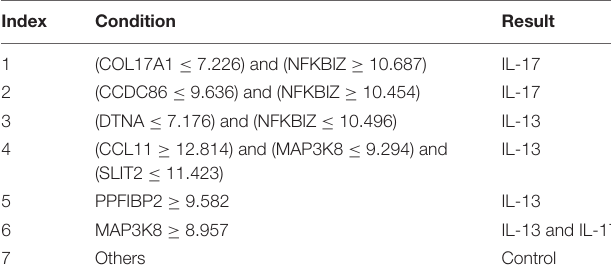
TABLE 3 | Rules by RIPPER on combined